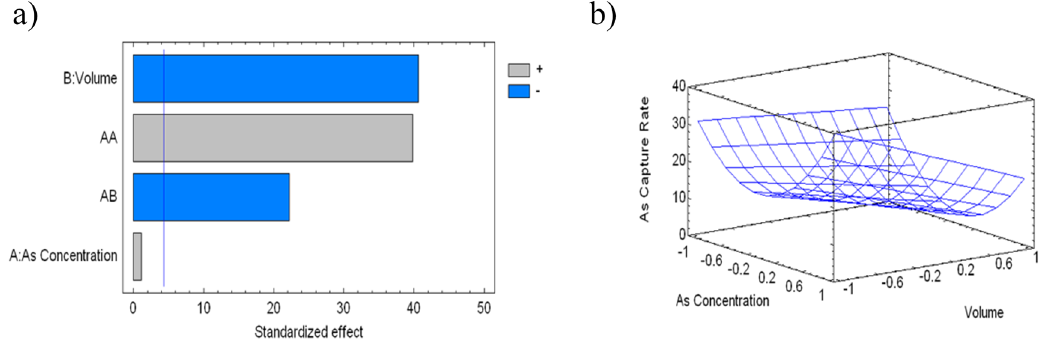
Figure 9. ( a ) Standardized Pareto chart for As capture rate, due to Q/VTMSO-SiO 2 filler treatment (where: A, As concentration; B, Eluted volume; and AB, AA and BB interactions. Blue line represents critical t -value, 95% confidence); and ( b ) estimated response